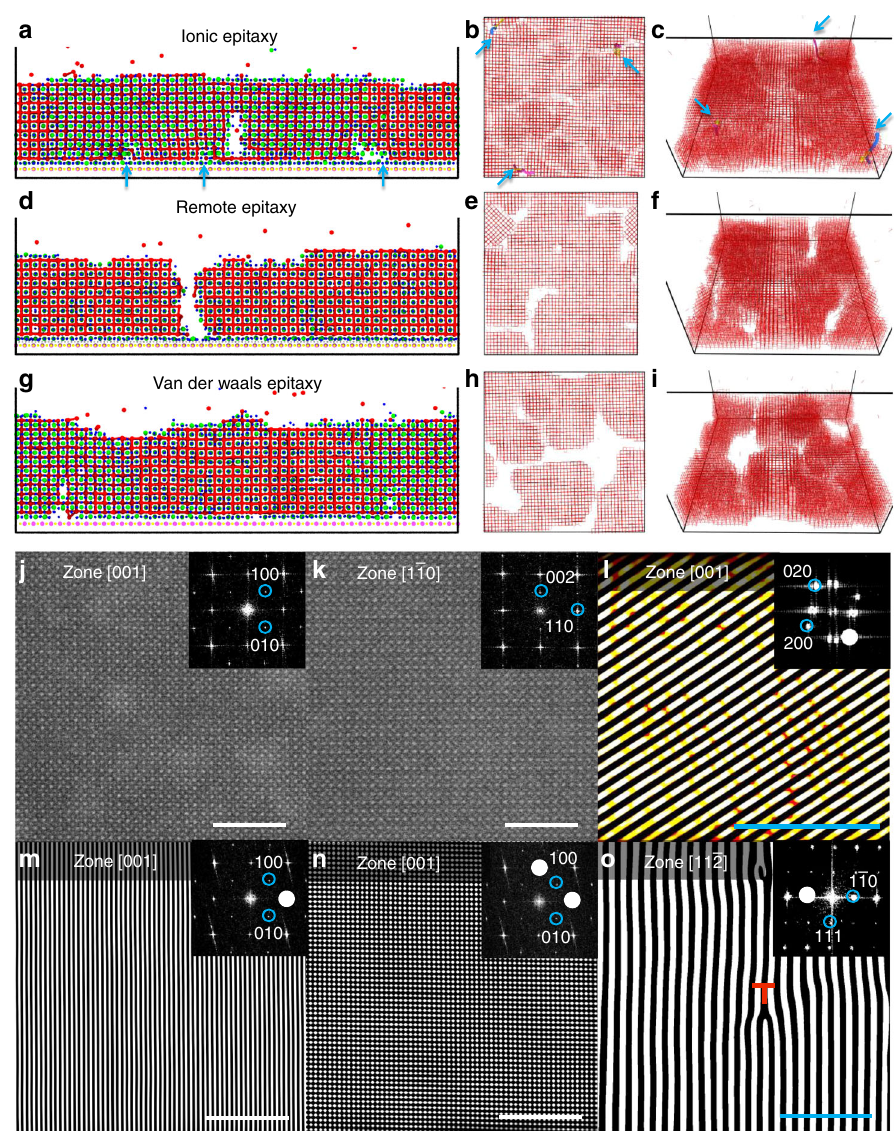
Fig. 4 Molecular-dynamics simulations of ionic epitaxy ( a – c ), remote epitaxy ( d – f ) and vdW epitaxy ( g – i ). a , d and g are side views. b , e and h are top views. c , f and i are bird views. Dislocations are indicated by blue arrows. j , k STEM images for different domains of CsPbBr 3 /Gr/NaCl with zone axes of [001] (j) and [1 (cid:1) 10] (k) and FFTs in their insets. l Inverse FFT of its inset transformed from the HRAFM image (Supplementary Fig. 19a) for CsPbBr 3 /Gr/ NaCl. m , n , Zoom-in inverse FFTs of their insets transformed from the STEM images Supplementary Fig. 10a, b for CsPbBr 3 /Gr/NaCl, respectively. o Inverse FFT of its inset transformed from the HRTEM image (Supplementary Fig. 21c) for transferred CsPbBr 3 . A dislocation is indicated in o . Scale bars of j , k , l , o are 5 nm. Scale bars of m , n are 10